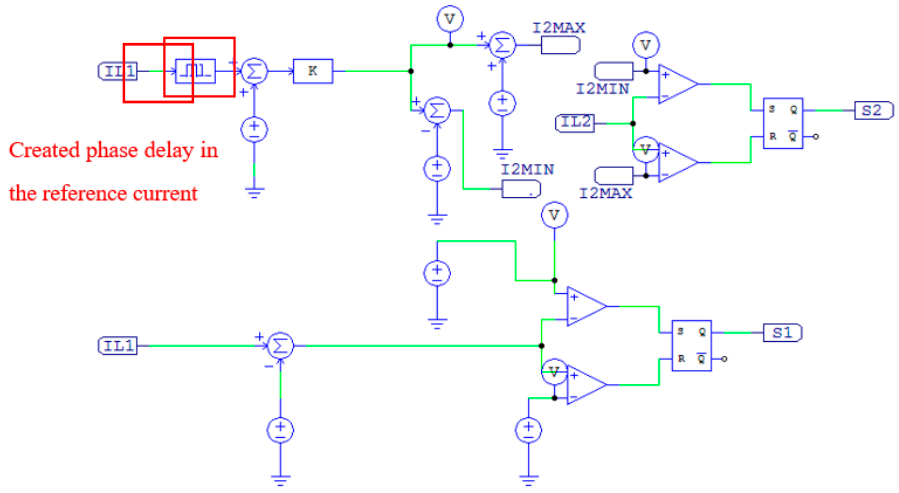
Figure 15. SMC Figure 15. SMC implementation.